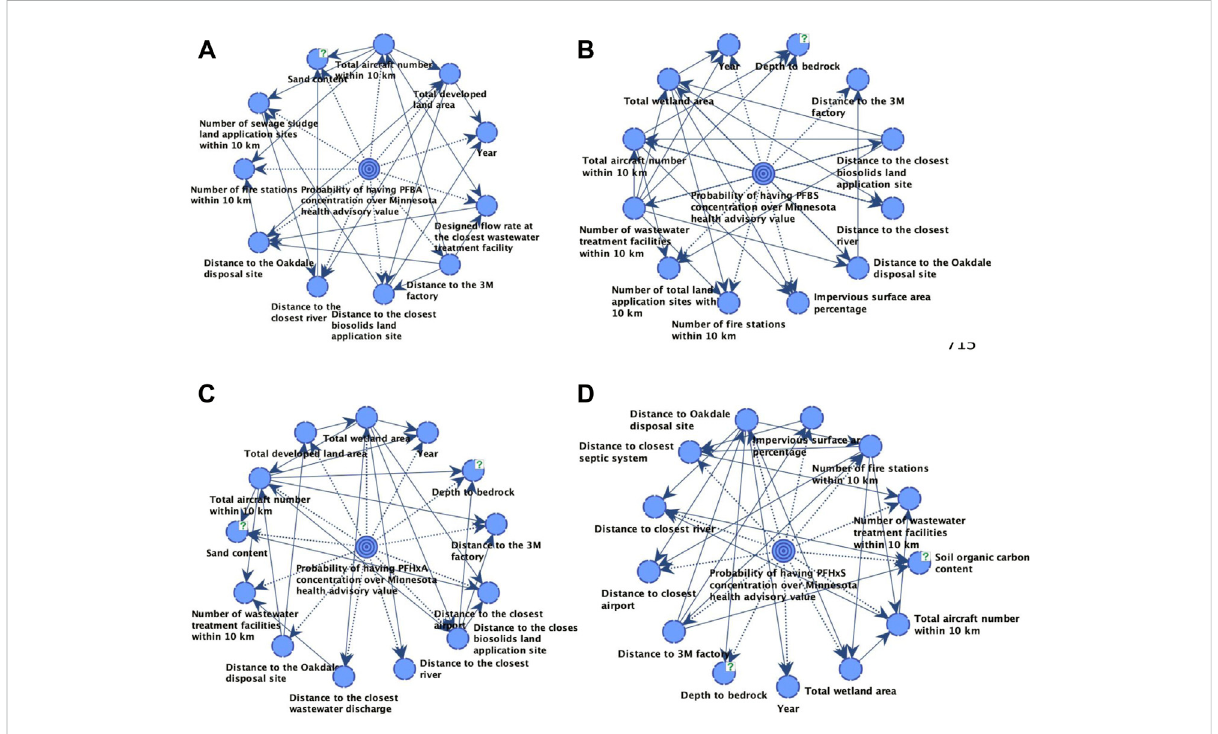
FIGURE 2 The directed acyclic graphs of (A) PFBA, (B) PFBS, (C) PFHxA, and (D)